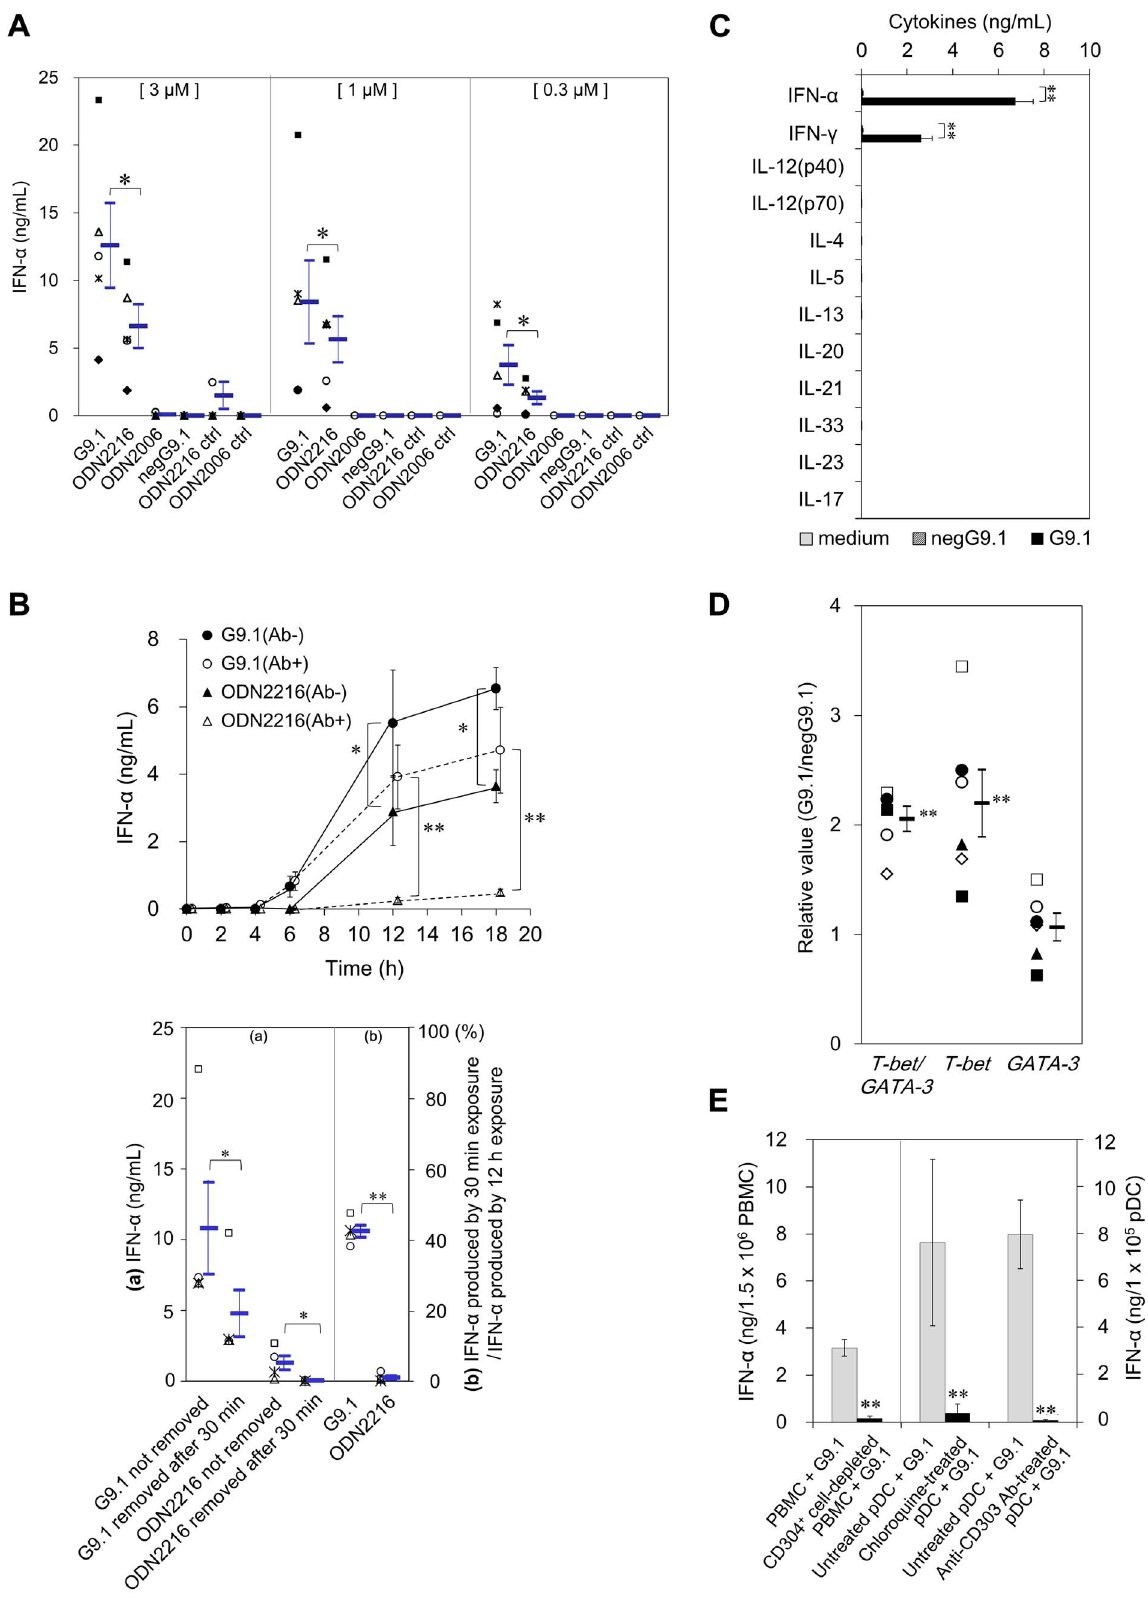
Figure 1. G9.1 stimulated T H 1-related cytokine production and transcription factor expression in human PBMCs. A , PBMCs (1.5 6 10 6 / mL) were cultured for 16 h with various concentrations of CpG ODNs or their negative controls. The IFN- a concentration released in the culture supernatant was measured by ELISA. (five donors; each symbol reflects an individual donor; * p , 0.05 between G9.1 and ODN2216). B , PBMCs